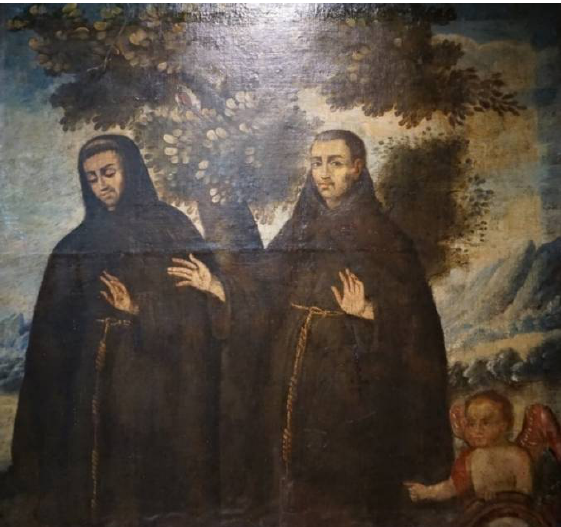
Figure 1. Anonymous workshop at Cusco. Monjes bajo un árbol ( Monks Beneath a Tree ). c. 1710. Oil on canvas. 112.5 × 116 cm. Pinacoteca Universidad de Concepción, Chile. Artwork in the public domain according to Chilean copyright law. Author photograph.